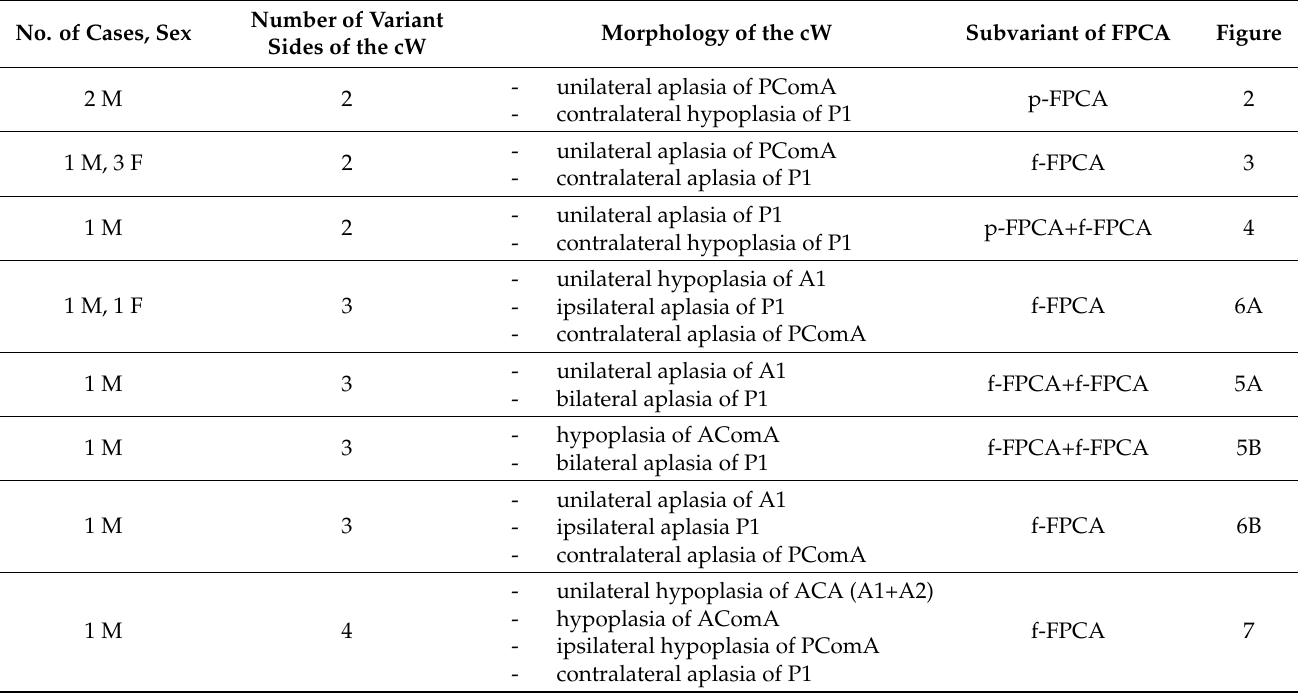
Figure 4. Postero-superior view of the cW. Bilateral FPCAs, partial and full/complete (p-FPCA+f- FPCA). Two variant sides of the cW: hypoplastic right P1 and aplastic left P1. 1. Left ICA; 2. A1 segment of the left ACA; 3. AComA; 4. Right ICA; 5. Right p-FPCA; 6. Right P1 hypoplasia; 7. BA; 8. Left f-FPCA. Table 2. Variant sides of the cW in cases with FPCA. M: male, F: